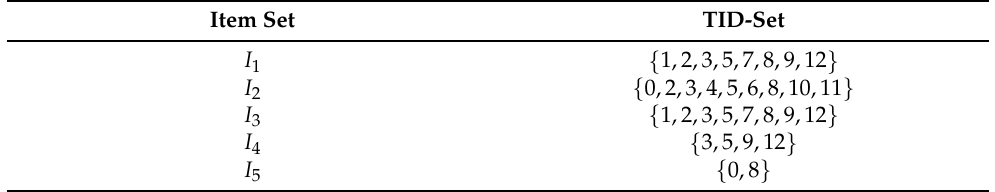
Table 5. Vertical data format transaction